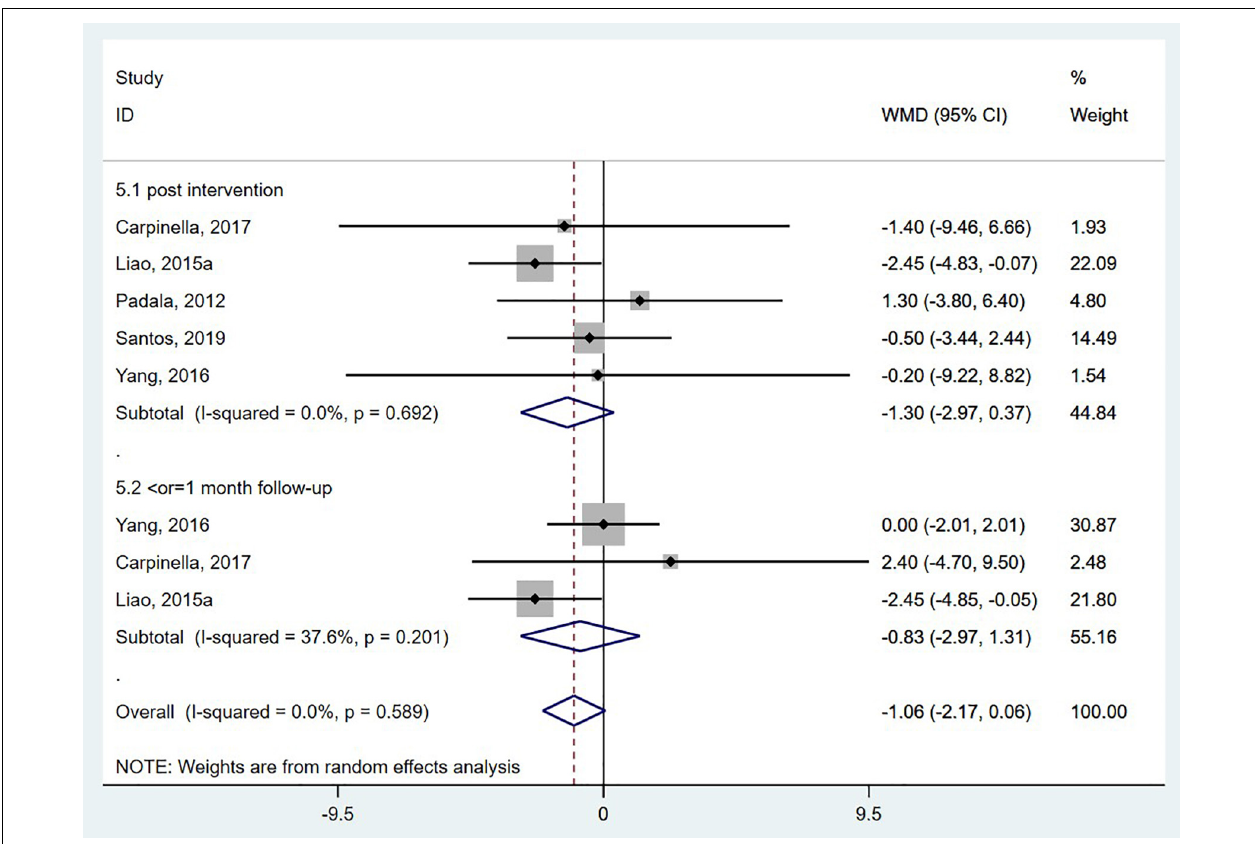
FIGURE 5 | Forest plot of pooled results for timed “Up and Go”